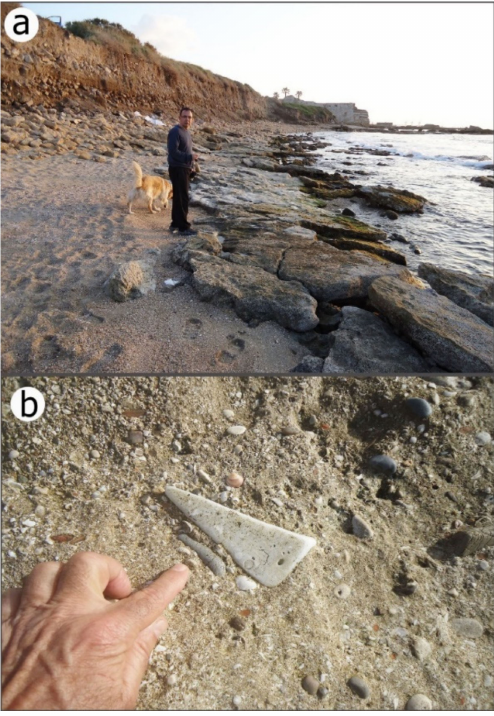
Figure 12. Beachrock north of the northern Crusader Wall: ( a ) general view looking south, ( b ) close up of a Roman marble item consolidated in the beachrock (for location see Figure 4 left panel marked with number